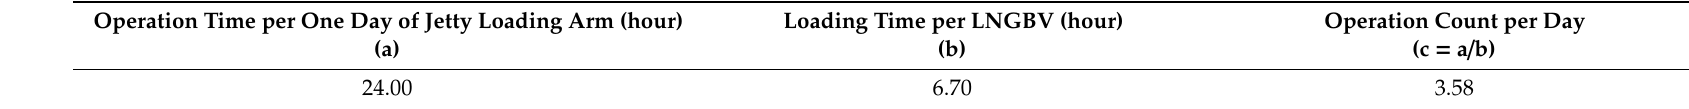
Table A12. Jetty Loading Arm’s Number of Operations per Day (Rotation Rate).